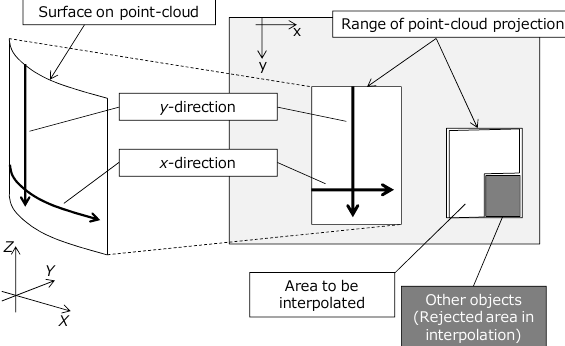
Figure 4. Point-cloud interpolation with a rectangular template in a range